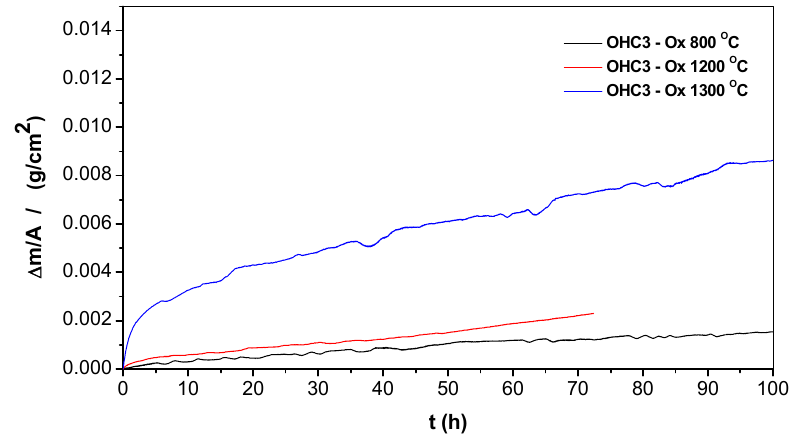
Figure 5. Mass change versus time data for isothermal oxidation at 800 °C, 1200 °C, and 1300 °C.